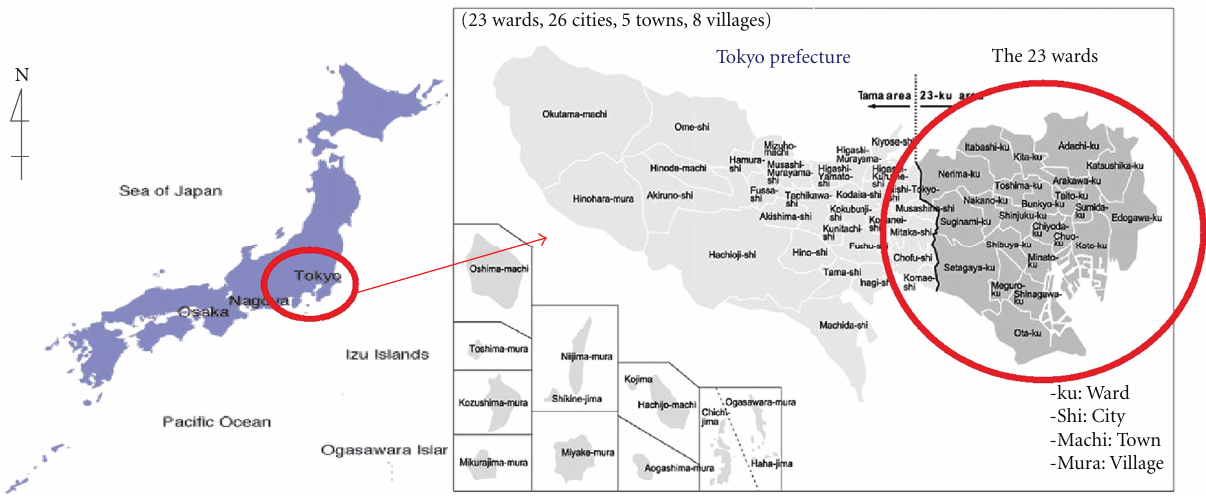
Figure 1: The location of the 23 wards of Tokyo metropolitan region in